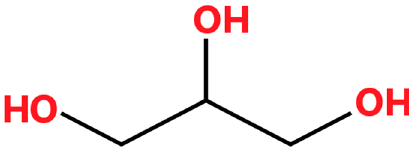
Figure 2. Chemical structure of glycerol.